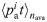
Analyses of the entropy as the result of spatiotemporal patterns.A minimalistic model was applied for the dynamics in the reduced networks with size N′ = 16, activation probabilities 〈pait〉nava, nava = 10 000 and t′ = 5 ms, as described in Methods section. The avalanches were compared using similarity matrix, and were subjected to an arbitrary threshold th = 0.7 in order to identify the similar patterns. The initial activated elements were not take into account. After this, we identified the number of different patterns and the maximum repeatability founded in each case. (A) The maximum repeatability of each case versus the σi deviation. (B) The entropy HA
versus the σi deviation. The associated K with the σi deviation is colour highlighted. Blue, red and black are related to K = 10, 100 and 1 000 respectively. The colourless circle is associated to the theoretical result where repetition is not observed.